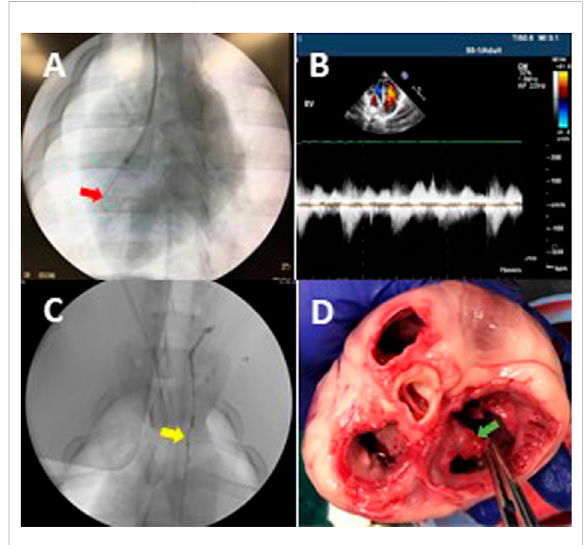
FIGURE 1 Animal model of tricuspid regurgitation (TR). (A) The fl uoroscopicimagerepresents that acutting device wasrotated to cut chordae tendineae in the right ventricle. The red arrow indicates thecutting device. (B) An ultrasonic imageindicates the re fl ux in the right atrium (i.e., TR) after chordae disruption. (C) The TD was visualized during contrast injection. The yellow arrow indicates the TD. (D) An example of the cutting device caused chordae disruption and the zigzag edge of a lea fl et in postmortem gross examination. The chordae of tricuspid lea fl ets were disrupted as desired (green arrow), which resulted in TR and elevated